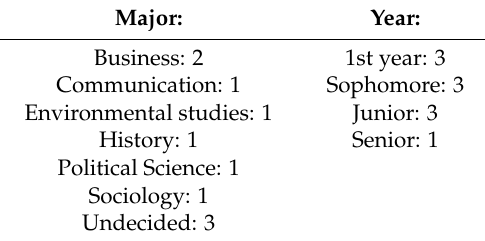
Table 4. White Interviewees (all American, born in US) ( n =